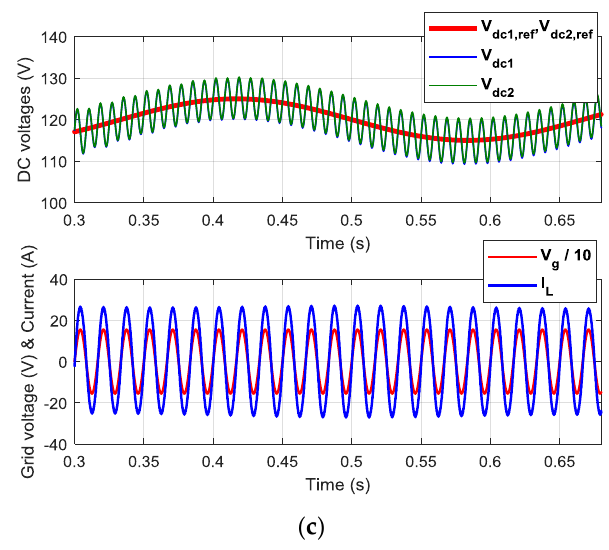
Figure 11. Simulation results for DC voltage control of the upper and lower H-bridge modules for the DC link voltage reference including a sinusoidal voltage. ( a ) results for 120 + 5sin(2 π × 3t)V voltage reference, ( b ) results for 120 + 5sin(2 π × 30t)V voltage reference, ( c ) 1-period enlarged waveform of ( a ).